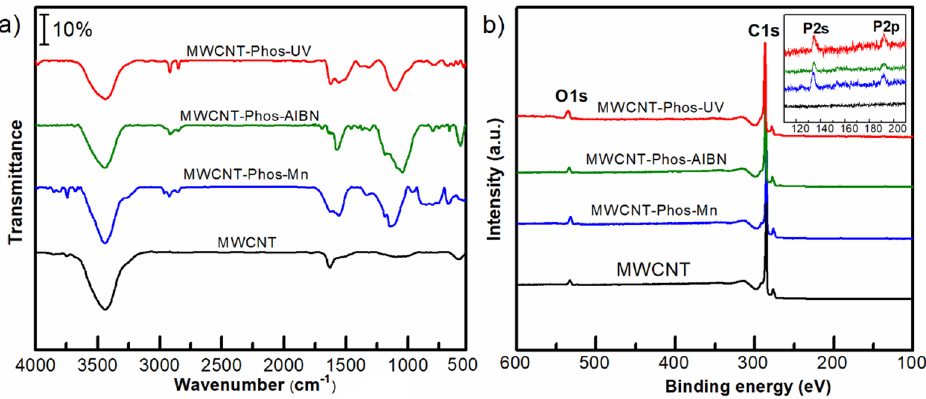
Figure 5. FTIR ( a ) and XPS survey ( b ) spectra of pristine and functionalized